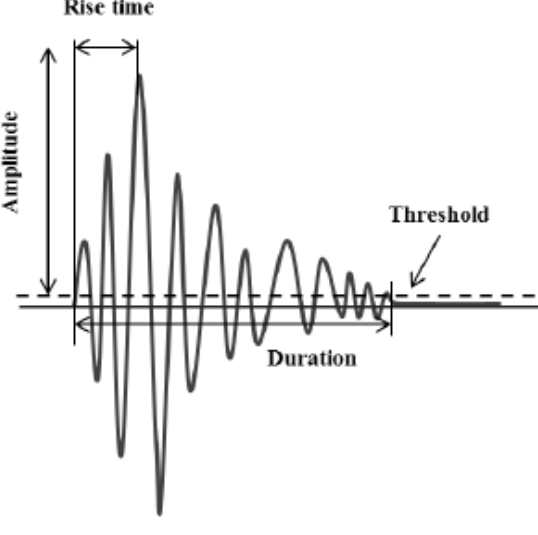
Figure 1. Typical acoustic emission signal with main waveform